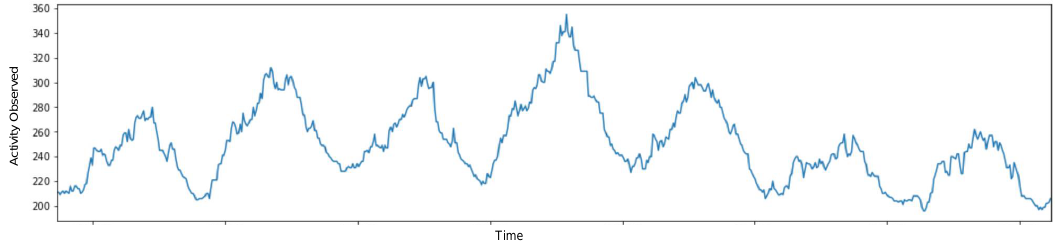
Figure 2. Number of mobile phones observed in a given cell during a seven days period. The number of mobile phones present in the cell appears to be periodic in time. It peaks between midday and the afternoon and reaches the lowest point between the midnight and the morning.